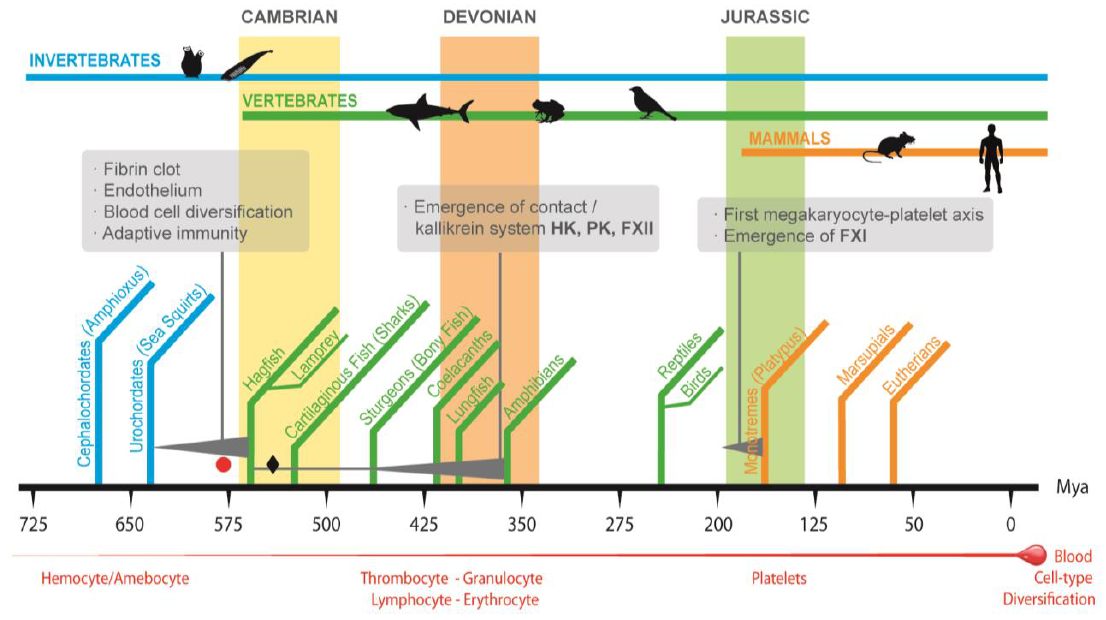
Figure 1. An overview of some of the main biological and environmental events in the evolution of the vertebrate coagulation system. The Cambrian radiation was preceded by a whole-genome duplication that, together with genetic variations in the form of gene duplication, exon shuffling, and simple mutation, led to a period of great innovations, including the emergence of organisms (the earliest jawless vertebrate agnathans similar to today’s hagfish and lampreys) with a simple version of coagulation system involving prothrombin, tissue factor, fibrinogen, FVII, and X. The emergence of the contact system and the integration into the vertebrate coagulation system was gradual, and it has been associated with the water-to-land transition of vertebrates and the appearance of the first amphibians somewhere around 400 – 390 Mya. The origin of the megakaryocyte/platelet axis (M/Pa) remains to be determined, but it might have occurred with the emergence of the first mammals around 200 – 166 Mya (the red circle and black diamond represent the points in evolution where the first and second whole-genome duplication events have been proposed to occur).